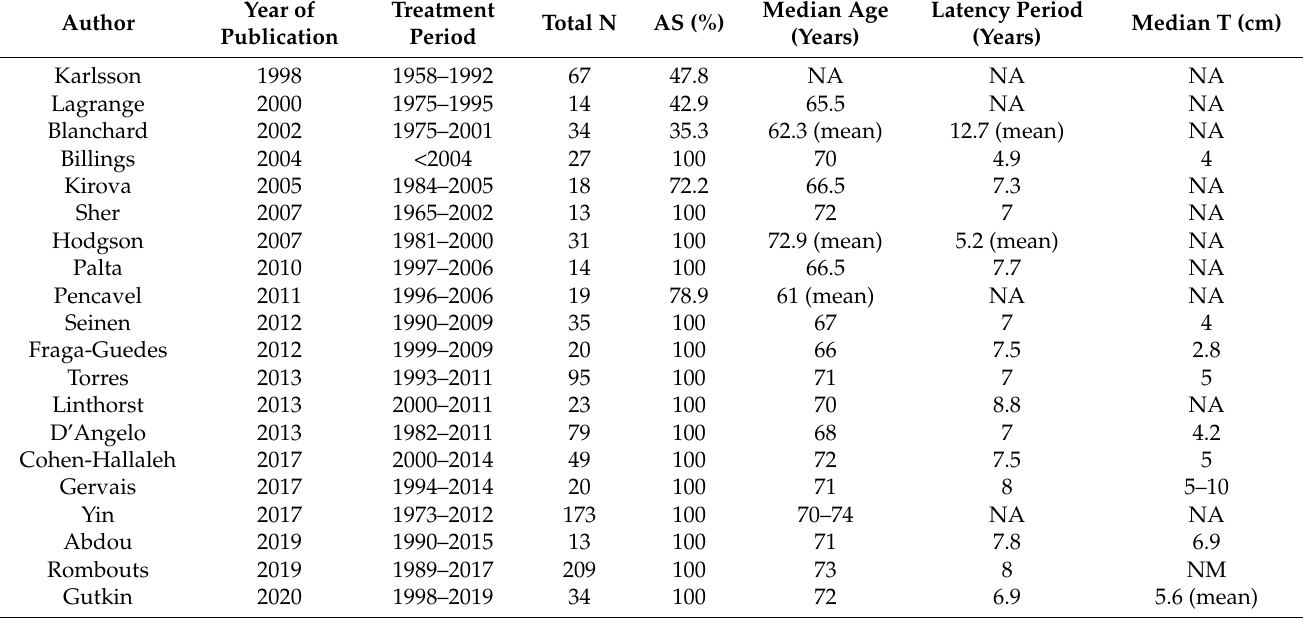
Table 2. Clinicopathological findings of retrospective studies including ≥ 10 cases of radiation-induced breast sarcoma (excluding bone sarcomas). The mean value of age at diagnosis and primary tumor diameter (T) is reported instead of the median, when the latter is not available. NA: Not